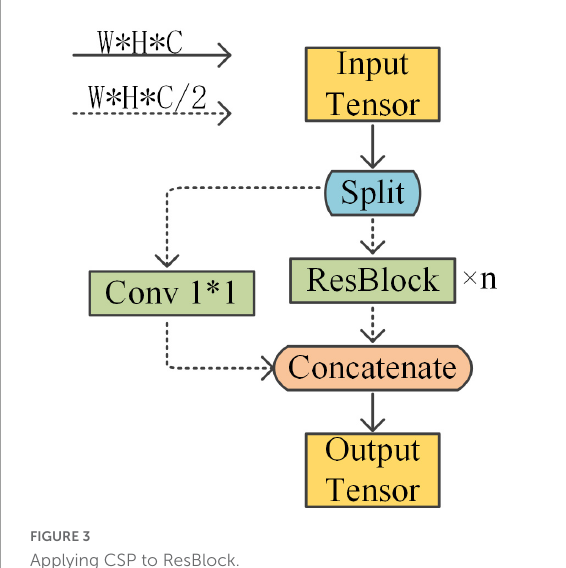
FIGURE3 Applying CSP to ResBlock.